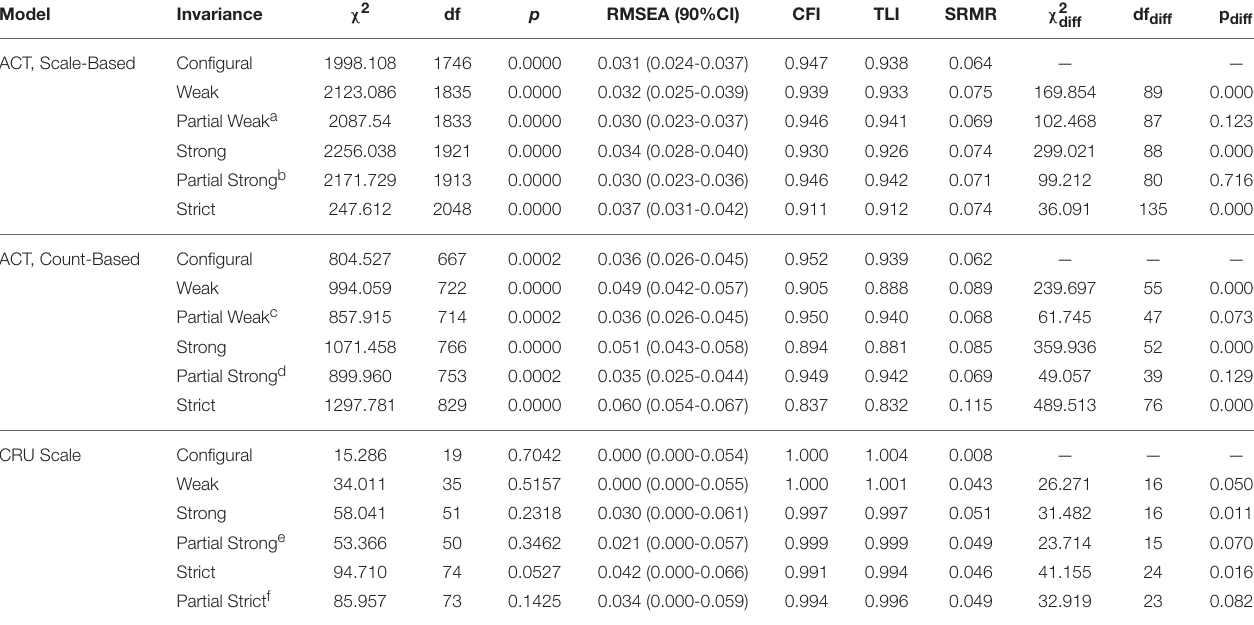
TABLE 11 | Results of the measurement invariance